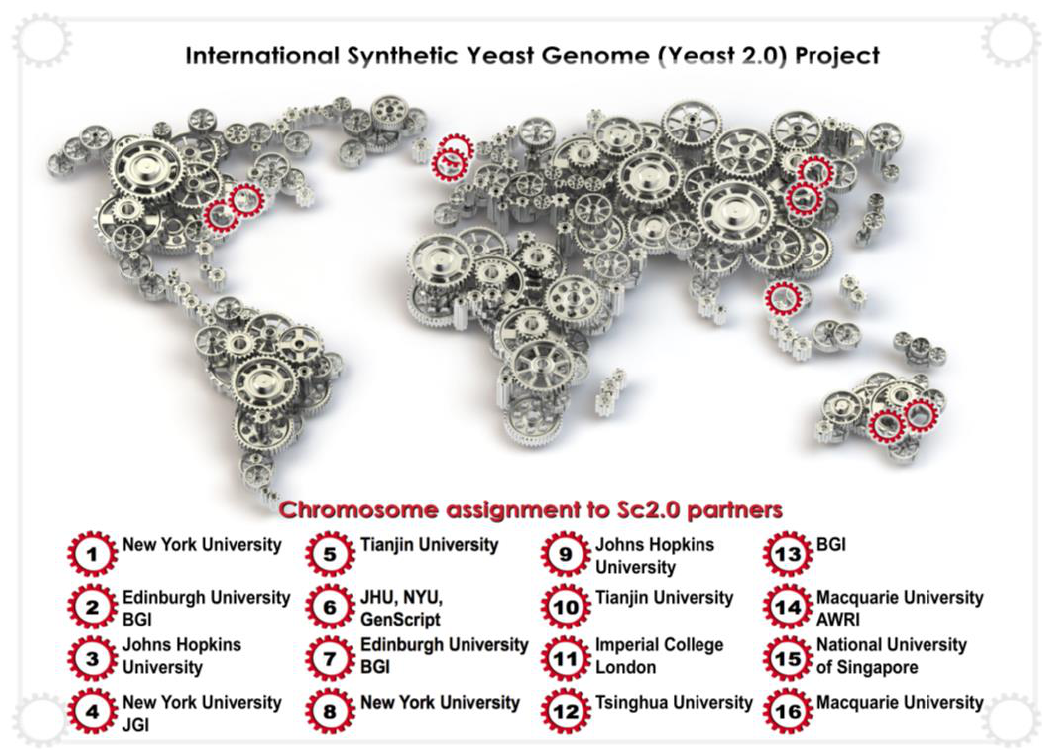
Figure 6. The Synthetic Yeast Genome (Yeast 2.0/Sc2.0) Project is an international endeavour. This